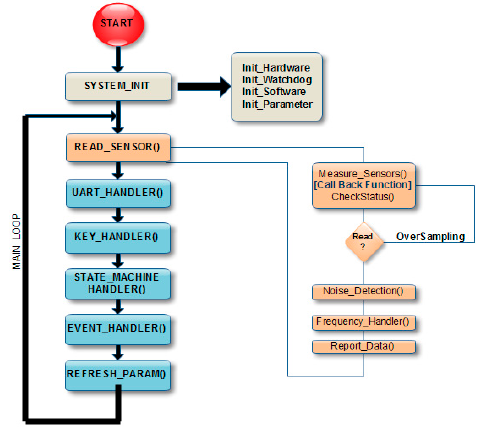
Figure B3. The flowchart of the main loop.